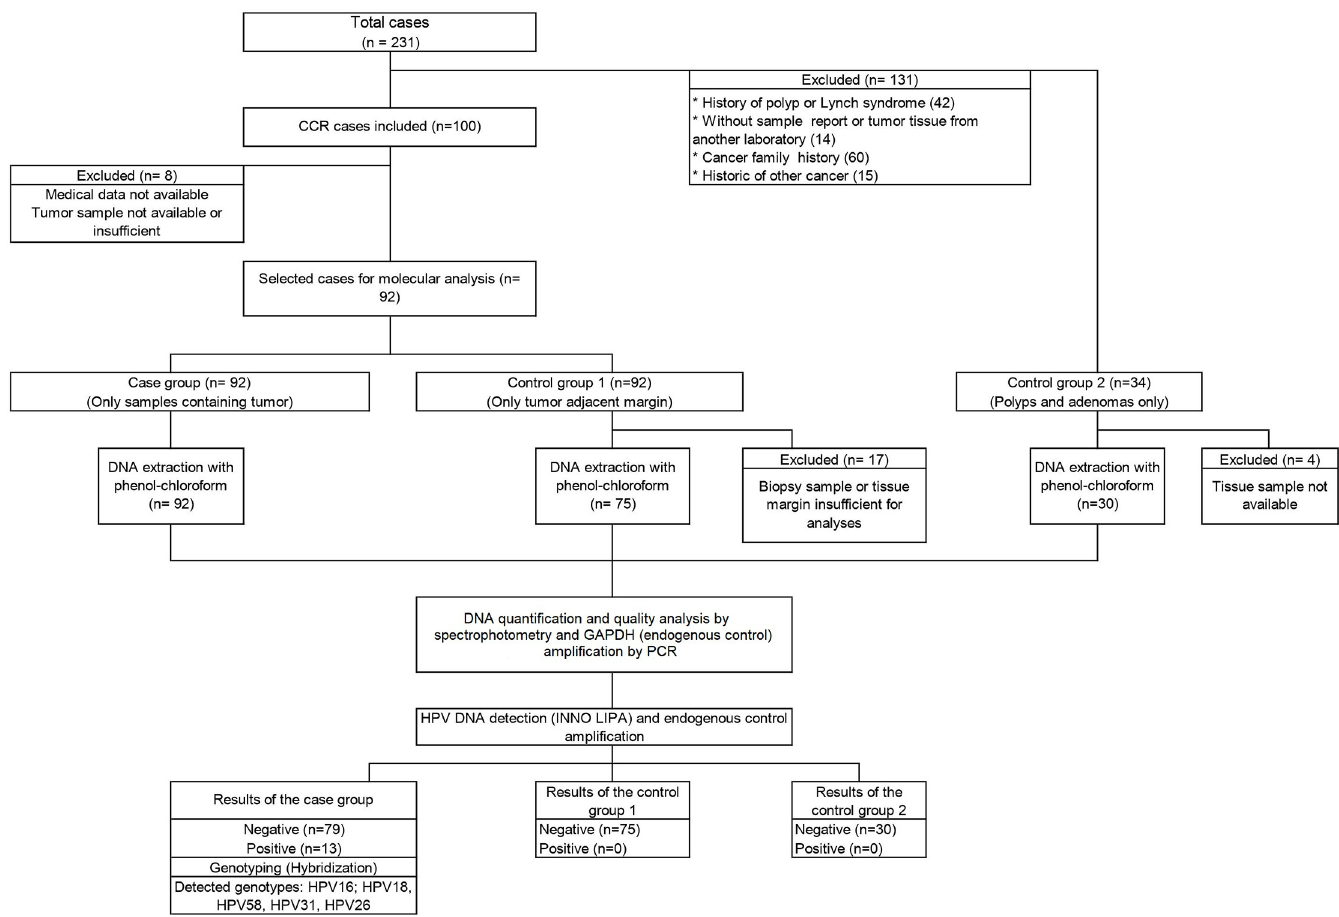
Fig 1. Flowchart of selection and analysis of the study